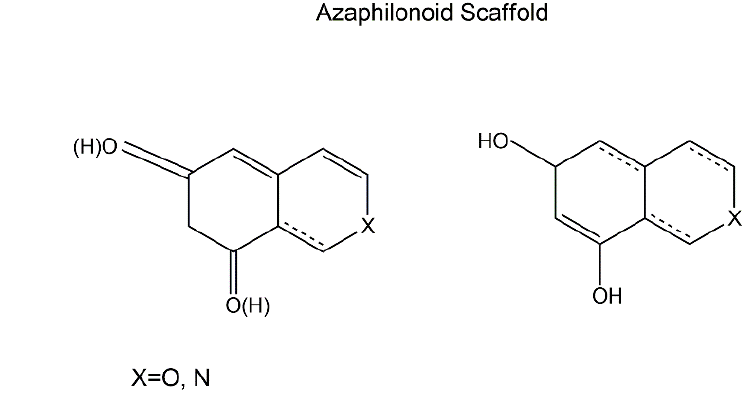
Figure 2. Azaphilonoid scaffold.